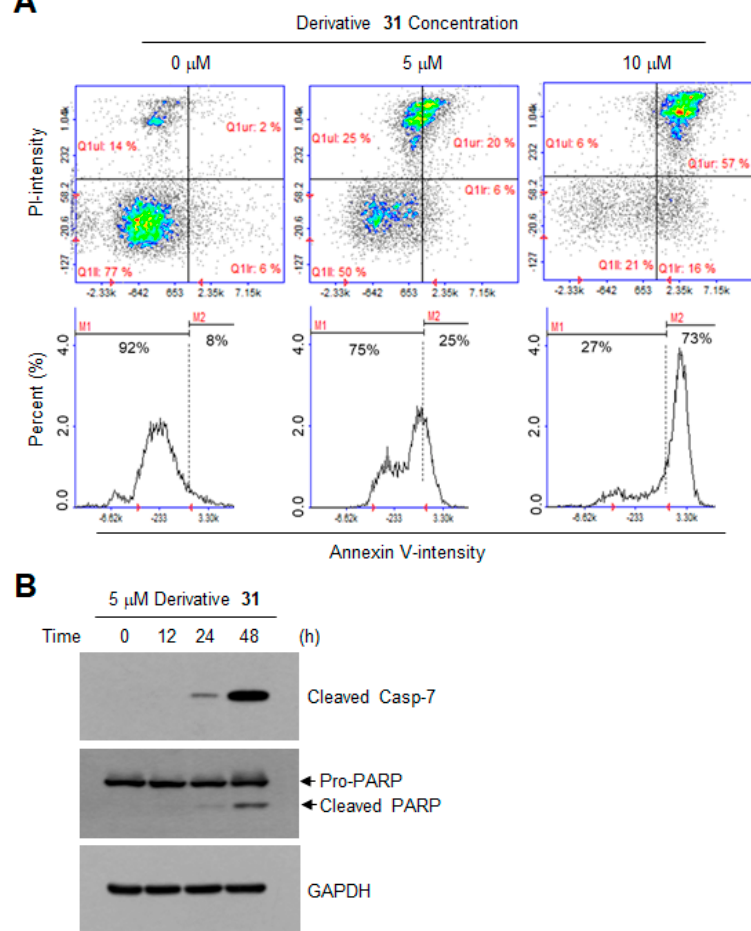
Figure 6. Effect of derivative 31 on apoptosis induction. ( A ) HCT116 cells were treated with derivative 31 at 0, 5 and 10 µ M for 48 h, and co-stained with fluorescein isothiocyanate (FITC)–annexin V and PI. Fluorescence intensity was analyzed by a NucleoCounter NC-3000 image cytometer. Scatter plots represent FITC–annexin V versus PI intensities (upper panels). Lower graphs represent populations of annexin V-positive cells. M1, annexin V-negative; M2, annexin V-positive. ( B ) HCT116 cells were treated with 5 μ M derivative 31 for 0, 6, 12 and 48 h, and total cell lysates were immunoblotted with antibodies against cleaved-caspase-7 and poly(ADP-ribose) polymerase (PARP). Anti-GAPDH antibody was used as an internal control.